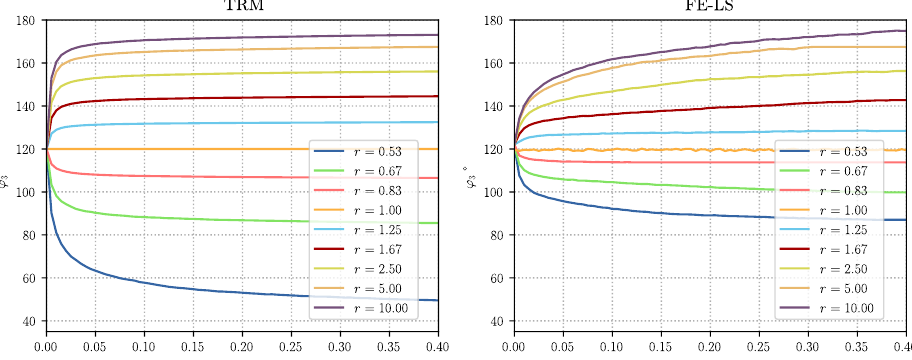
Figure 4. Triple junction test case: Evolution of the ϕ 3 angle for different values of r , ( left ) TRM and ( right ) LS-FE models. The plotted data for the LS-FE model was taken from [8].